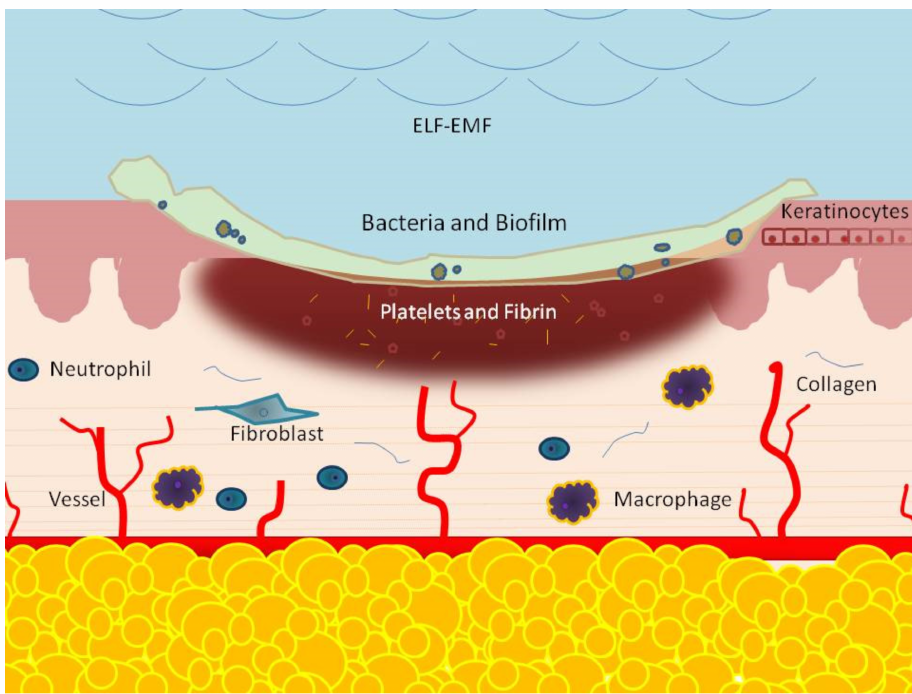
Figure 2. The chronic wound shows the presence of infection and biofilm formation, a hyperprolif- erative and nonmigratory epidermis, and an inflammatory state with an increase in inflammatory cells (neutrophils and macrophages) not properly functioning. Fibroblasts and keratinocytes be- come senescent while there is a reduction of angiogenesis, stem cell recruitment and activation, and ECM remodeling. ELF-EMFs has been shown to regulate the inflammatory response, induce senescence of fibroblasts, and keratinocytes through increased proliferation and migration. The regulation of MMP and collagen synthesis improves the ECM microenvironment. Proangiogenic and vasculogenic activity support cells with nutrition and oxygen. The role on biofilm and infection is still